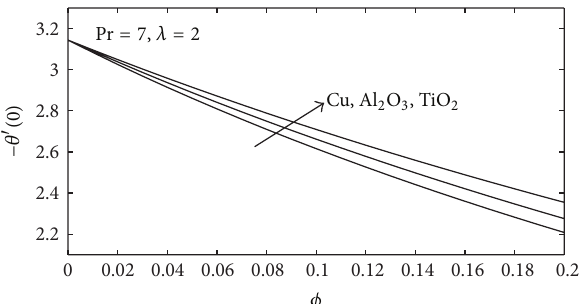
Figure 9: Variation of −𝜃 󸀠 (0) with 𝜙 for different types of nanopar- ticles when Pr = 7 and 𝜆 = 2 .